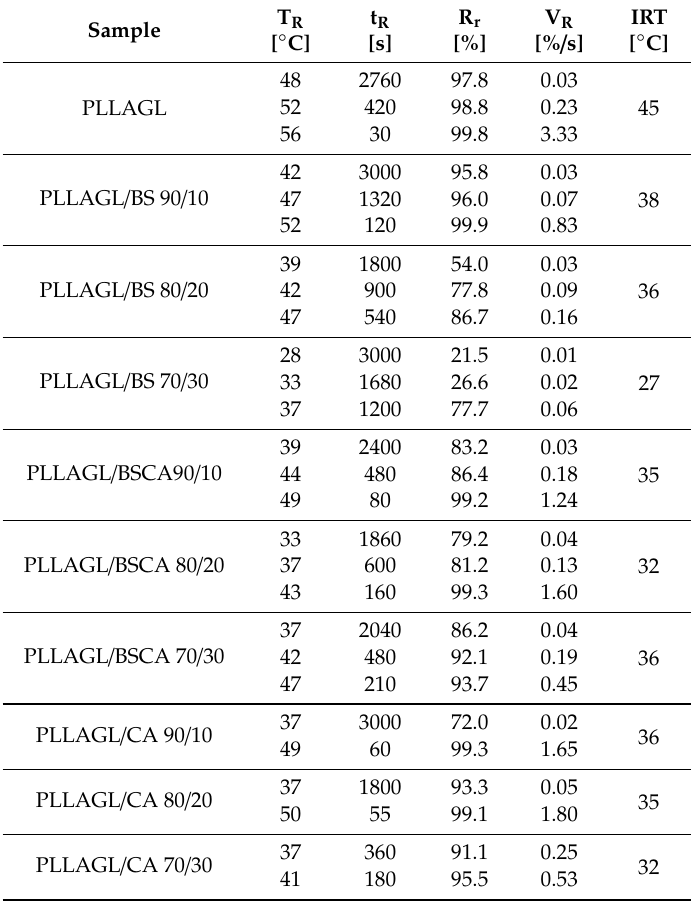
Table 3. Shape memory parameters of